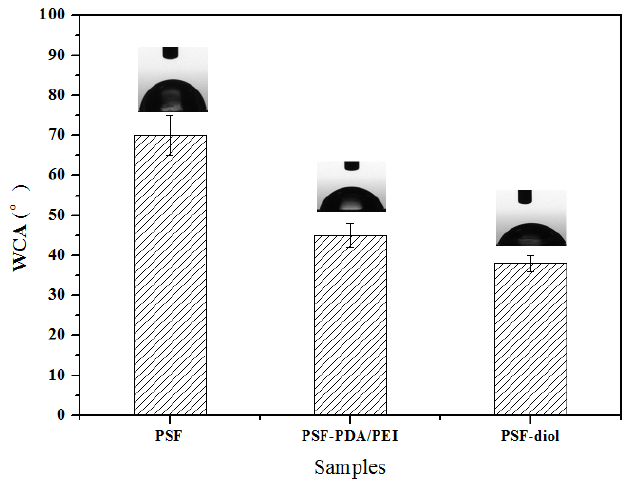
Figure 8. Water contact angle (WCA) of PSF, PSF-PDA/PEI, and PSF-diol membranes.